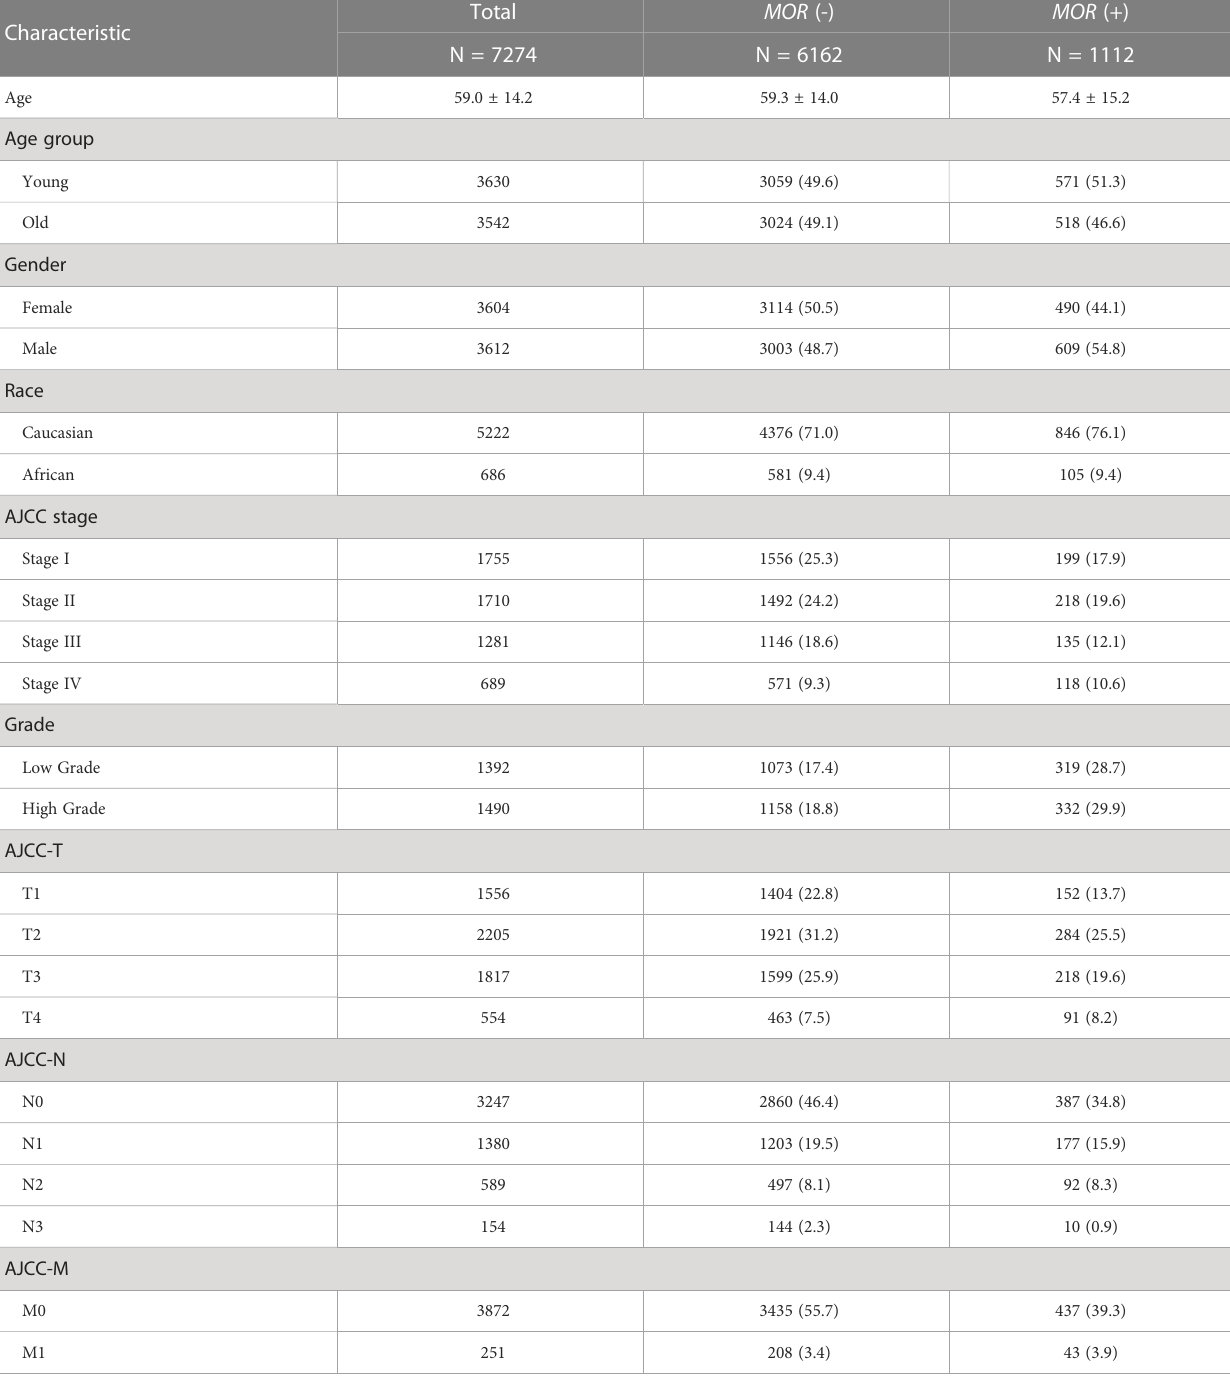
TABLE 1 Baseline characteristics of the included patients in the TCGA